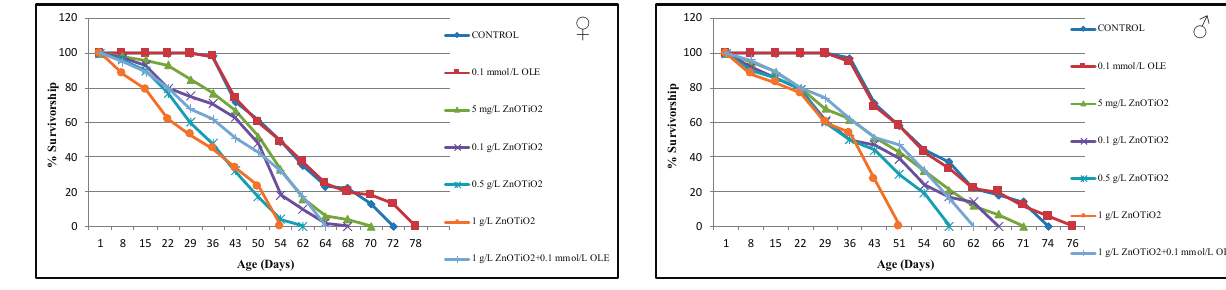
Figure 2. Exposure to ZnOTiO 2 and OLE in female adult D. mela- nogaster leads to lifespan alteration.